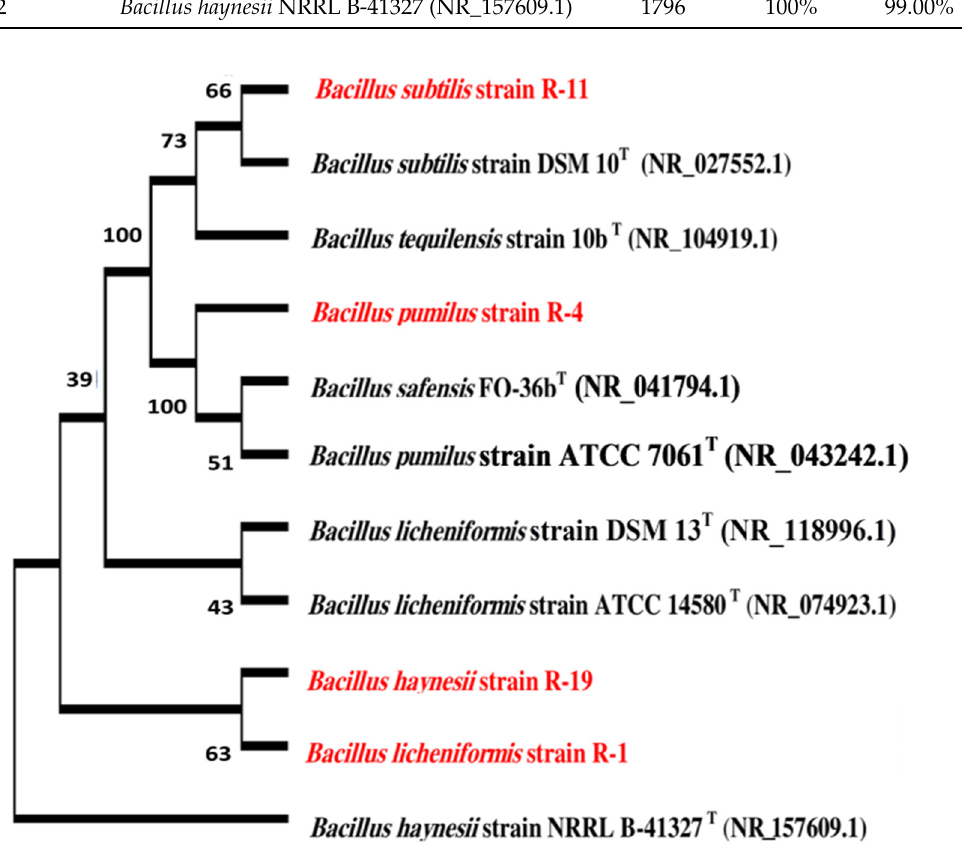
Figure 5. Phylogenetic relationship between our identified isolates (colored in red) and the most related type strains (labeled by (T)).